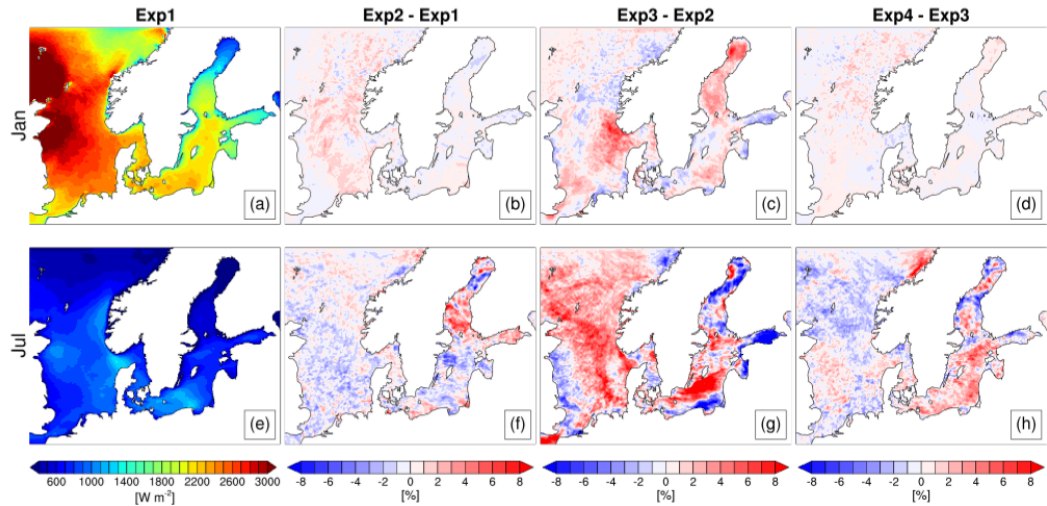
Figure 5. Results for wind power density (WPD) from different experiments (columns) and the different months (rows) where the top row shows results for January and the bottom row for July (2015). Column 1 ( a , e ) represents the mean WPD from the control experiment Exp1. Column 2 ( b , f ) the influence of wave–atmosphere interaction on WPD (normalized, unit %), i.e., Exp2–Exp1. Column 3 ( c , g ) shows the effect of adding atmosphere–ocean interaction in the simulations of WPD, i.e., Exp3–Exp2 (normalized, unit %). Column 4 ( d , h ) shows the effect of included influence of wave–current interaction when simulating WPD (normalized, unit